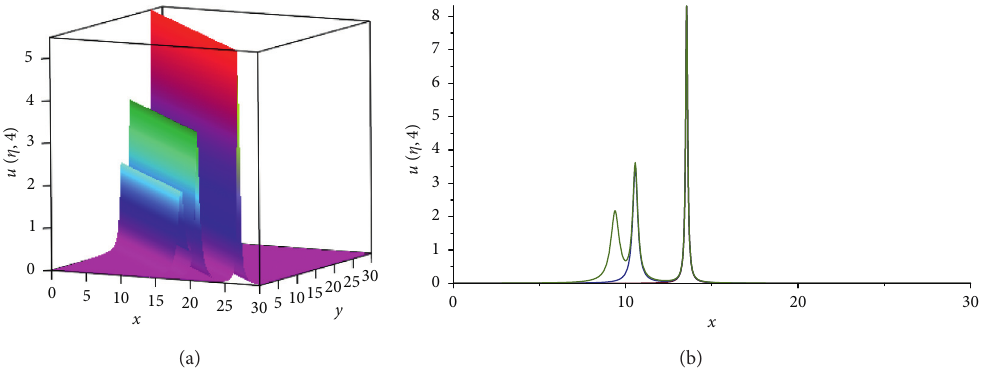
Figure 2: The fission of an algebraic gravity solitary wave at t � 4. (a) Space diagram. (b) Planar graph.